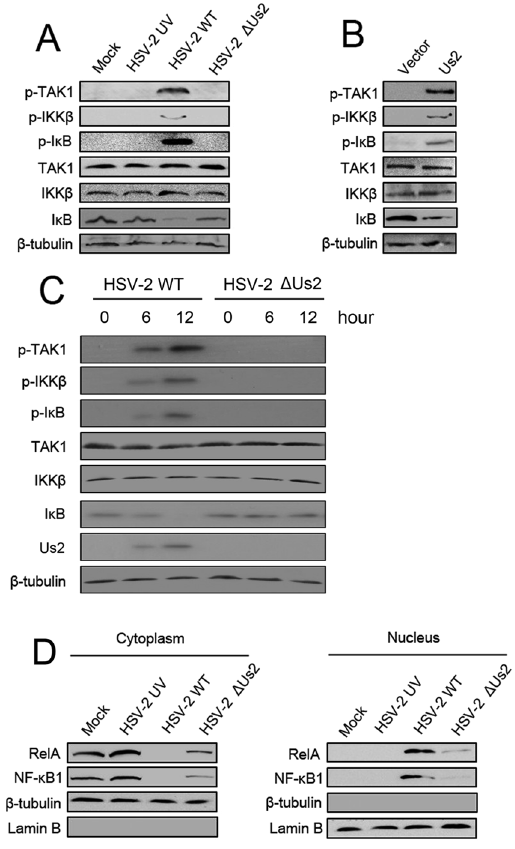
Figure 4. Us2 activates TAK1 and the downstream signaling pathways. ( A ) End1/E6E7 cells were infected with indicated viruses for 12 h prior to western blot analyses. ( B ) End1/E6E7 cells transfected with pCMV- Us2 or control vector for 24 h prior to western blot analyses. ( C ) End1/E6E7 cells were infected with HSV-2 WT or HSV-2 Δ Us2 for indicated times prior to western blot analyses. ( D ) End1/E6E7 cells were infected with the indicated viruses for 12 h. Cytosolic and nuclear extracts were prepared and subjected to western blot analyses. Lamin B and β -tubulin were used as markers for nuclear and cytosolic fractions, respectively. All experiments were repeated at least three times with similar results. Bar graphs represent the mean ± SD, n = 3 ( * P < 0.05, ** P <